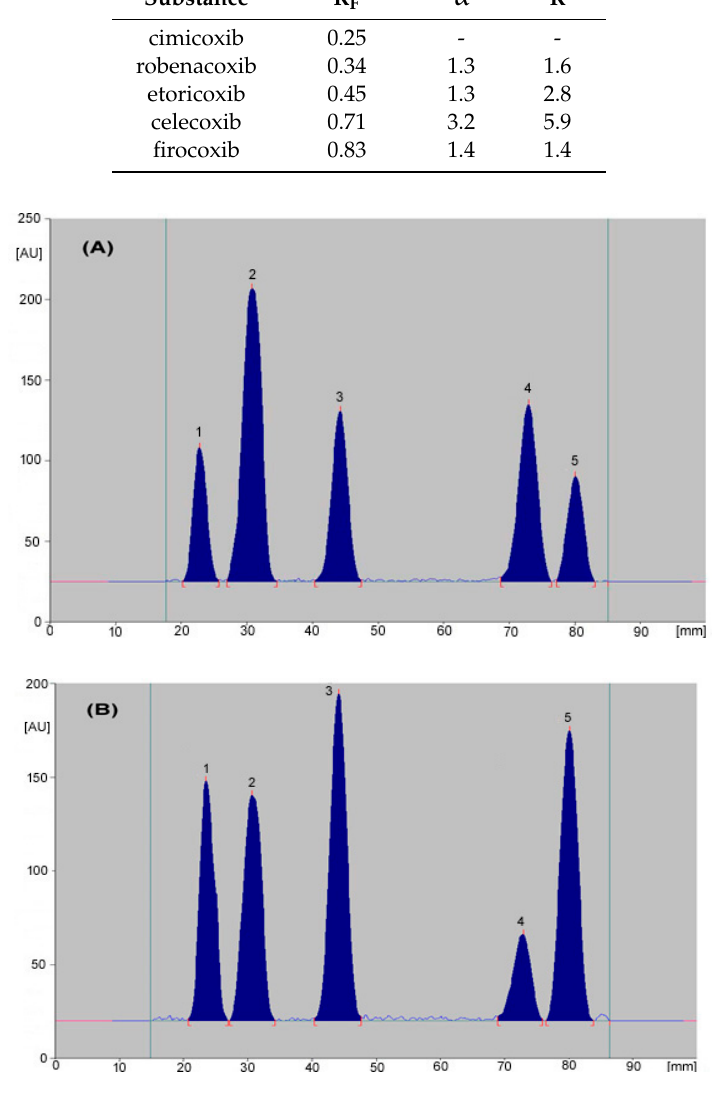
Figure 2. An example of densitograms obtained for a mixture of standard substances at 254 nm ( A ) and 290 nm ( B ) (1-cimicoxib; 2-robenacoxib; 3-etoricoxib; 4-celecoxib; 5-firocoxib).